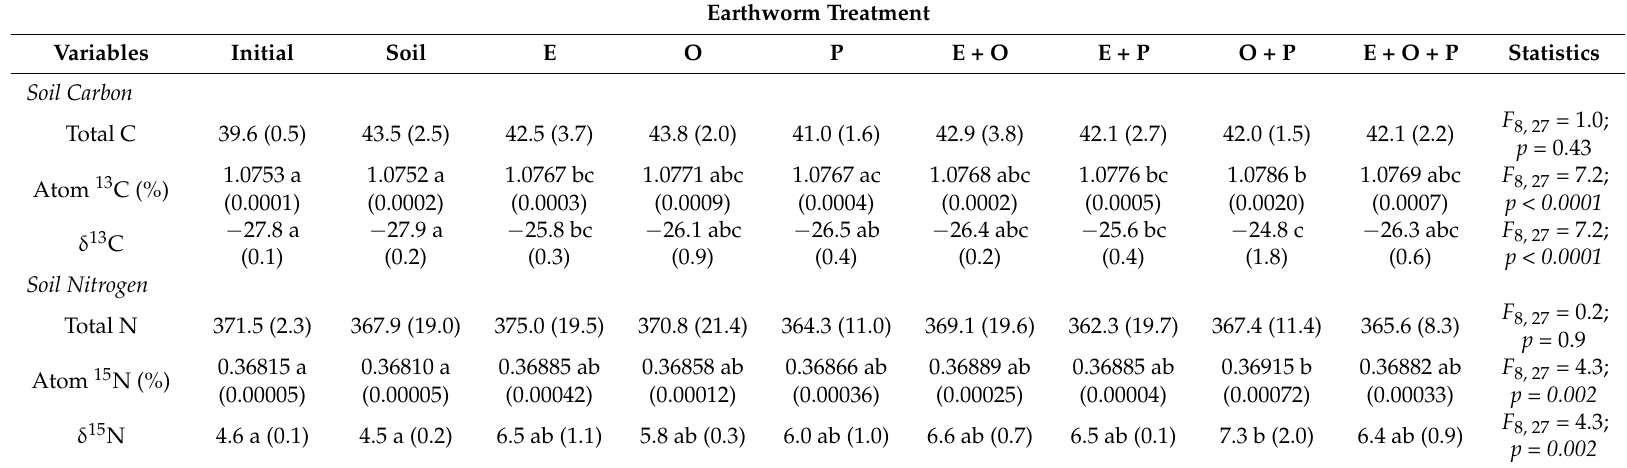
Table 2. Total soil carbon (mg C/ g soil) and nitrogen ( µ g N/ g soil), atom percentages of 13 C and 15 N (%) and delta 13 C ( δ 13 C; ‰) and delta 15 N ( δ 15 N; ‰) from the initial soil samples (no isotope-labeled materials and no worms at Day 0; Initial), control treatment (no isotope-labeled materials and no worms at Day 22; Soil) and earthworm treatments at the end of the 22-day mesocosm experiment with Puerto Rican